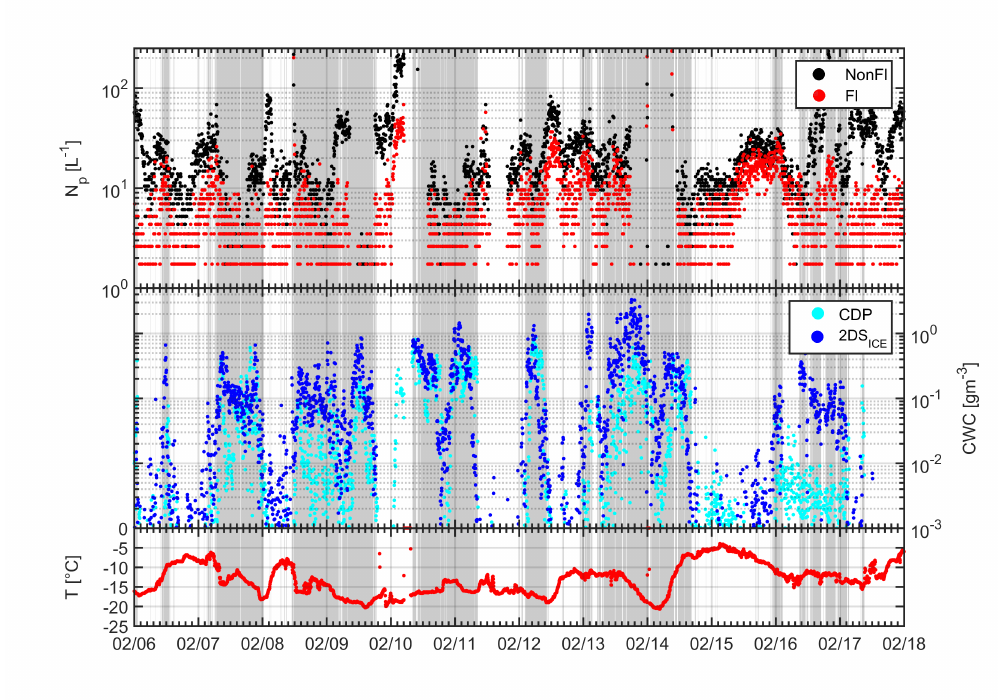
Figure 5. Top panel: time series of total fluorescent, N Fl , (red) and total non-fluorescent, N NonFl , (black) aerosol concentrations measured with the WIBS-4 sampling from the total inlet (TI). Middle panel: liquid (cyan) and ice (blue) water contents measured with the CDP-100 and 3V-CPI-2DS. Bottom panel: temperature. Box and whiskers denote 5th, 25th, 50th, 75th, and 95th percentiles. Grey shaded areas denote in cloud periods (TWC ≥ 0.01gm − 3